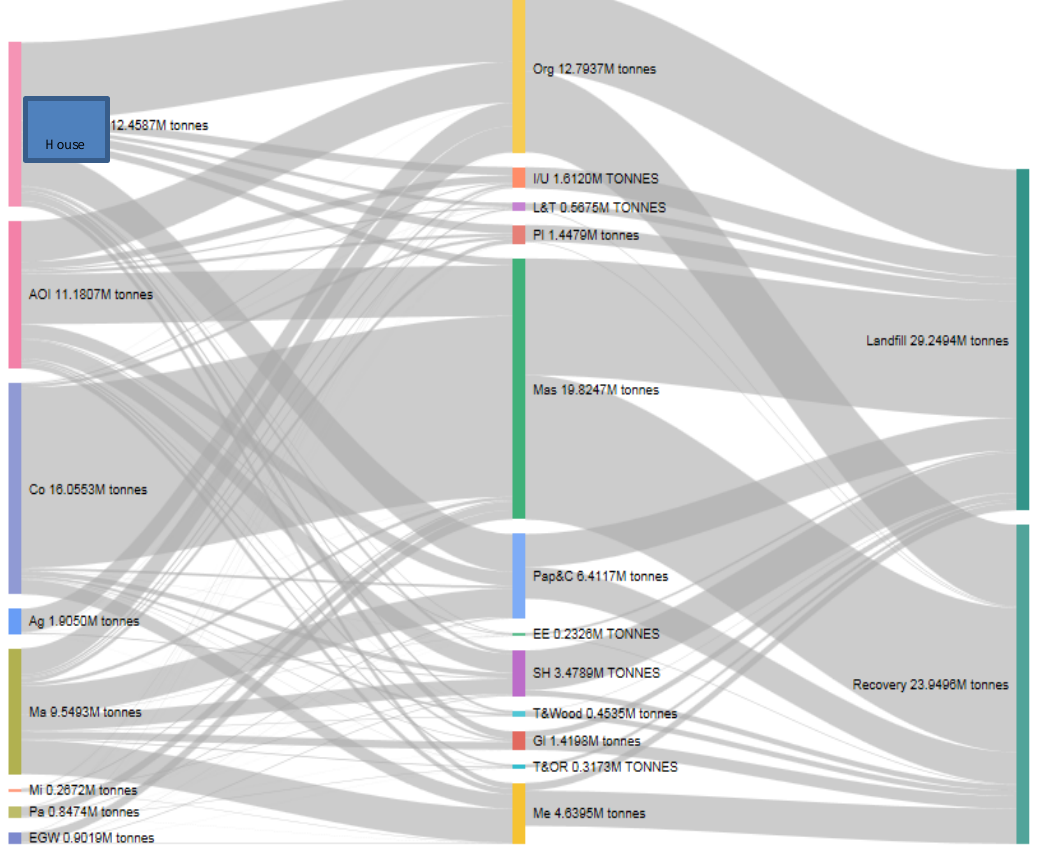
Figure 7. Physical flow of waste footprints in the Australian WIO table in 2009–2010; waste generated by intermediate sectors (left) and the households (left), sorted into 12 categories (middle), and dealt with by two waste treatment methods (right). Final demand refers to the households. Agriculture, forestry, and fishing = AG; Mining = MI; Manufacturing = MA; Electricity, gas, and water = EGW; Waste management services = WMS; Construction = CO; Public administration = PA; All other industry = AOI.